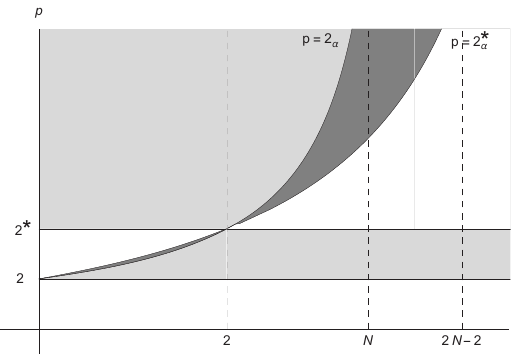
Figure 1: Regions of nonexistence of solutions (light gray), and existence (white with p > 2) and nonexistence (dark gray) of radial